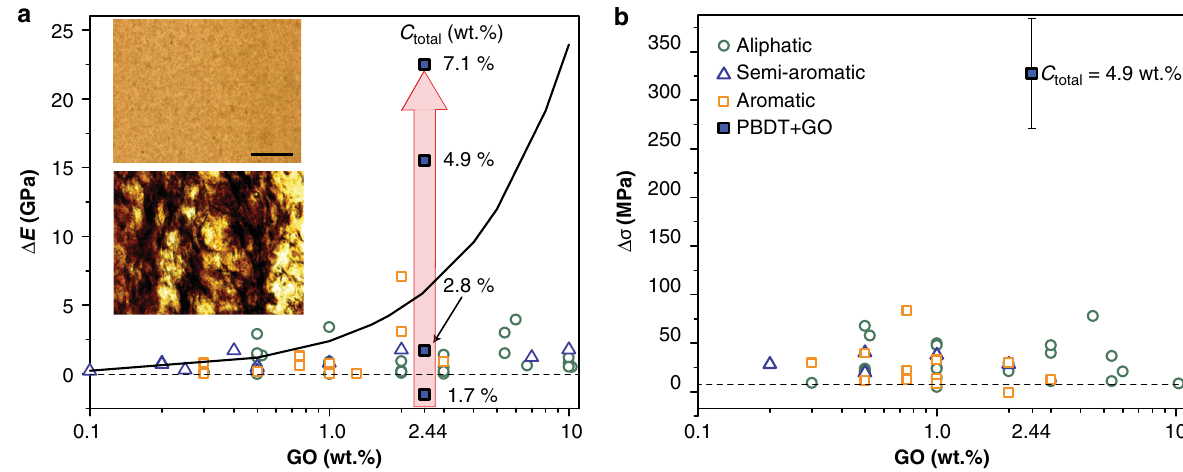
Fig. 4 Mechanical properties of PBDT + GO nanocomposites. a The enhancement in storage modulus ( E ’ ) from dynamic mechanical thermal analysis for PBDT + GO nanocomposites (denoted by fi lled blue squares). The differences between the maximum fi lm modulus of GO nanocomposites ( E NC ) and the corresponding values of polymer matrix modulus ( E PM ), Δ E , is tabulated for literature data for different classes of polymers (aliphatic, semi-aromatic, and aromatic denoted by open-turquoise circles, open blue triangles and orange squares respectively) reported for either dynamic thermo-mechanical analysis ( E ’ ) or tensile measurements ( E ) of fi lms. Theoretical estimate for Δ E was calculated from the rule of mixtures 3 using densities of 1.4 and 2.0 g.cm − 3 for PBDT and GO respectively, E GO = 250 GPa, GO aspect ratio = 3500 and perfect in-plane orientation within the nanocomposite; Δ E is invariant for E PM values in the 0.1 – 10 GPa. For PBDT + GO nanocomposites, the Δ E strongly depends on C total of the hybrid fi lm casting mixture; Δ E = 23 GPa is obtained for PBDT + GO fi lms when cast from C total = 7.1 wt.%. Optical microscopy images of nanocomposites also indicate that GO dispersion quality is also dependent on C total . The scale bar (200 µ m) is the same for both optical microscopy images. b Strength enhancement from tensile stress-stress measurements. The Y-error bar represents the standard deviation from the average. The enhancement Δ σ = ( σ NC − σ PM ) is the difference between the nanocomposite ’ s maximum tensile strength ( σ NC ) and that of the polymer matrix ( σ PM ); while σ NC is dependent on the GO loading, Δ σ does not show any signi fi cant correlation with GO content. Reported Δ σ values for GO-polymer nanocomposites are indicated for optimum GO loadings for a variety of polymer matrices (see Supplementary Data 1); for PBDT + GO nanocomposite cast from C total = 4.9 wt.% h N b mixture, Δσ = 320